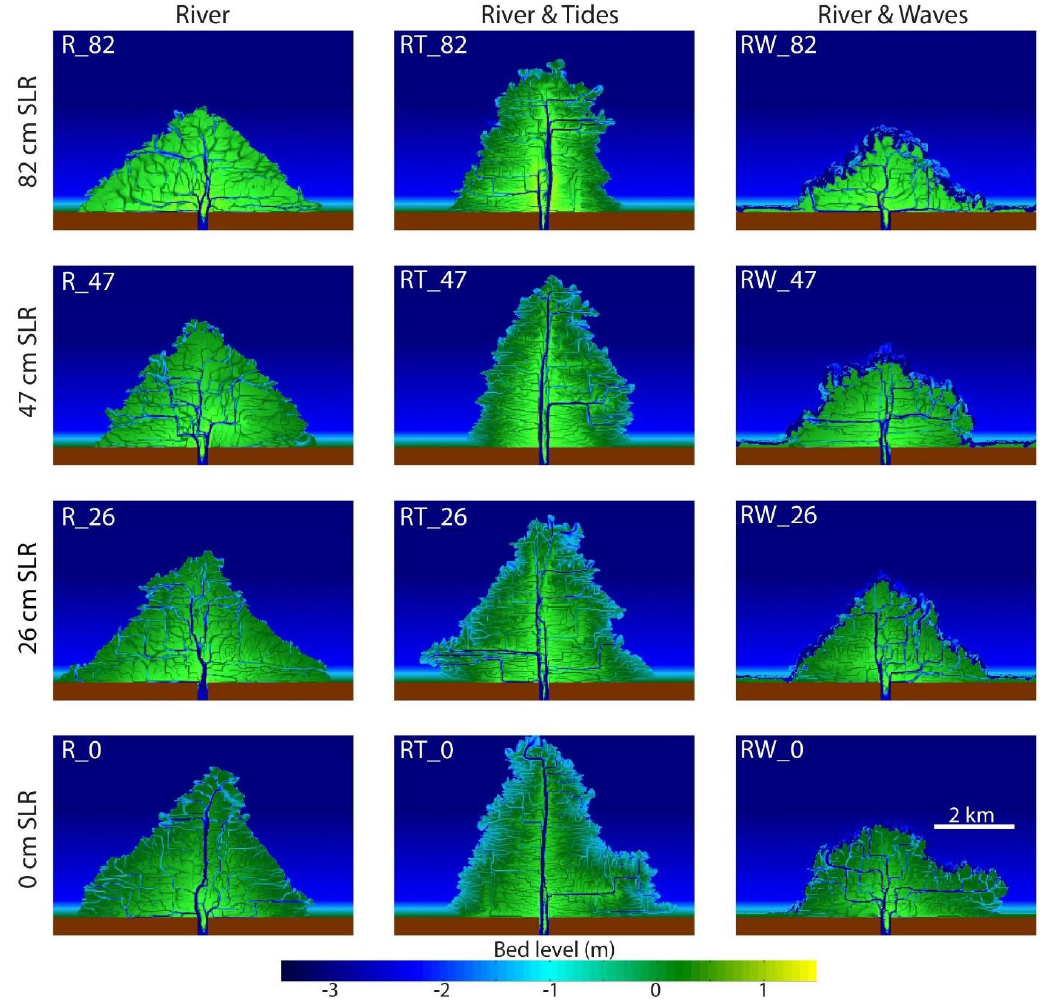
Figure 1. Deltaic bed levels (m) after 100 model-days, approximately corresponding to 100 years of natural evolution. Delta coast morphology as a function of coastal forcing ( left : river discharge, middle : tides, right : waves) and sea-level scenario (from 82 cm at the top row to 0 cm at the bottom row). Animated videos of all scenarios showing delta dynamics over time are available as Supplementary Files.